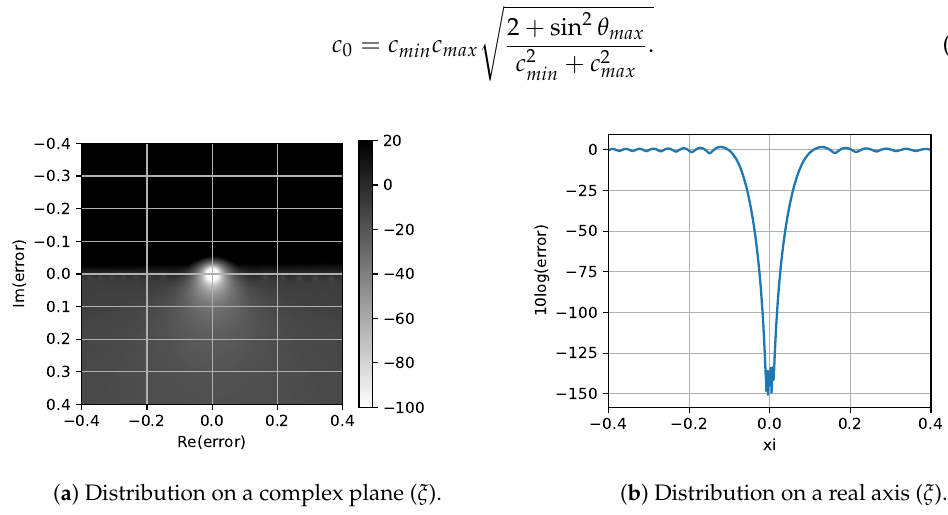
Figure 2. Distribution of error 10log R ( ∆ x , ξ ) when ∆ x =